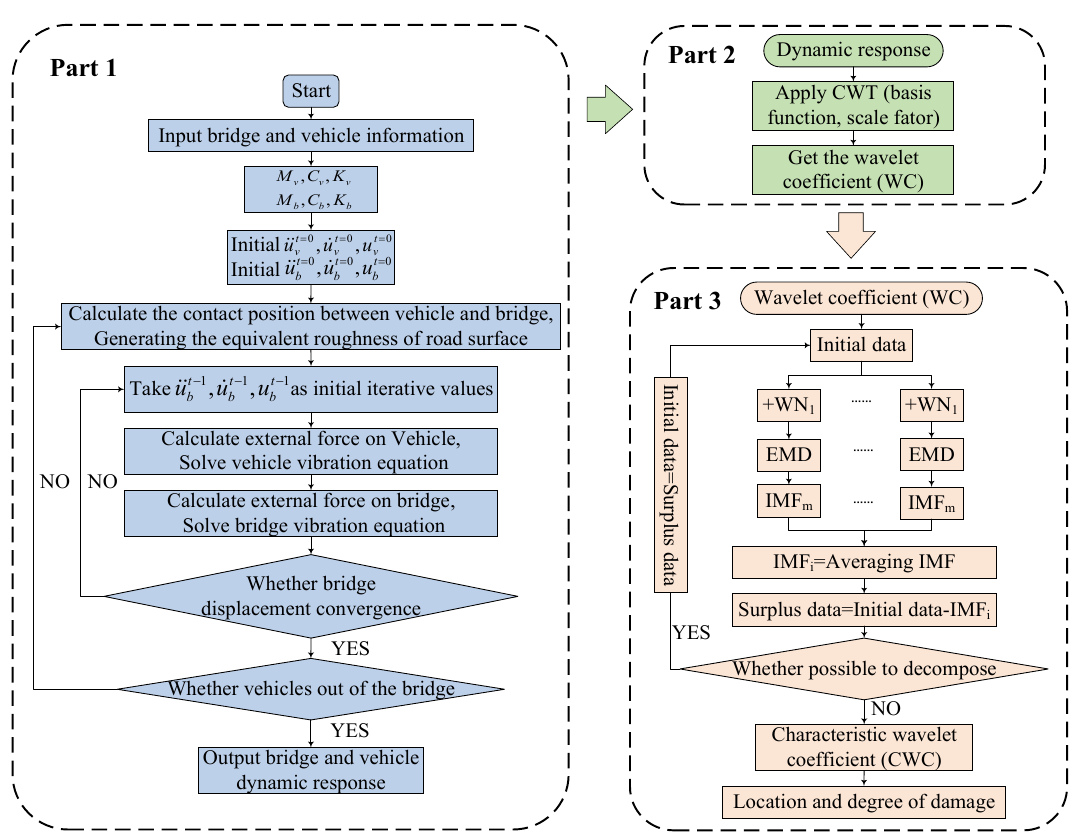
Figure 1. Flowchart of the proposed drive ‐ by bridge damage inspection methodology.